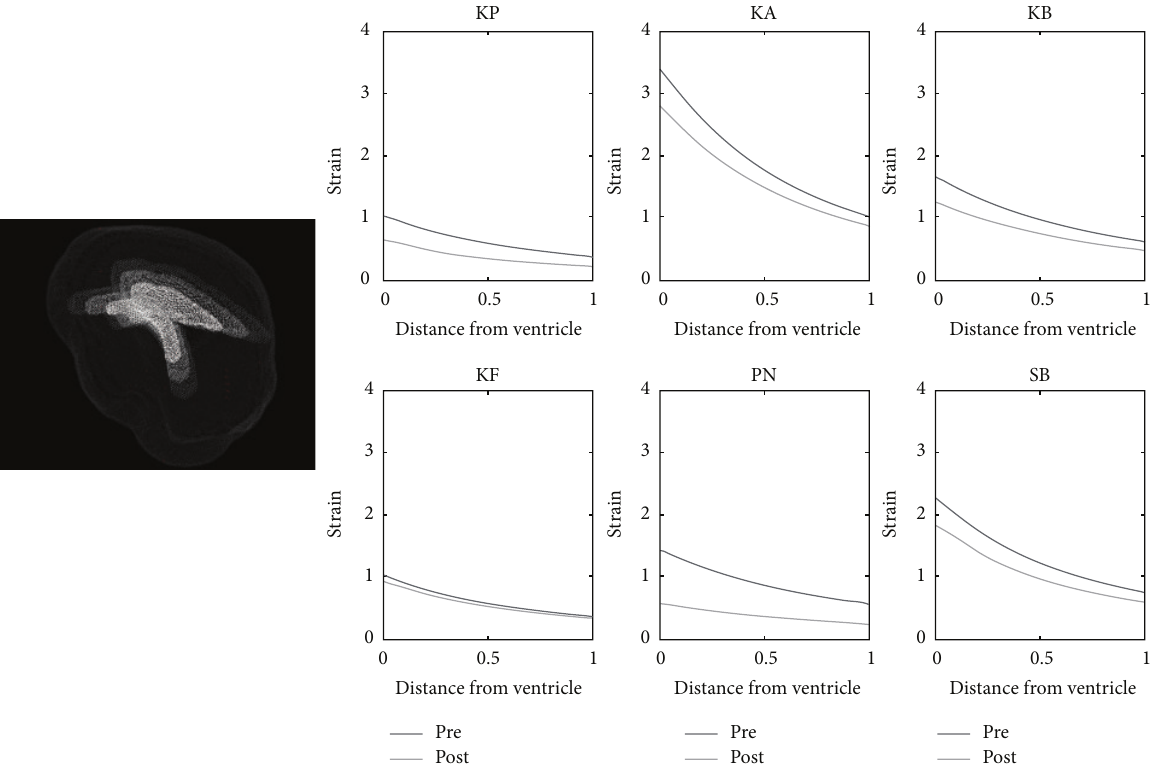
Figure 5: Relationship between the distance from the lateral ventricles and the mean strain level of brain tissue. The picture on the left illustrates the interpolated different-sized ventricles which were used for average strain level calculation at different distances. A decreased strain level was found after the neurosurgical procedure in all of the 6 patients in various